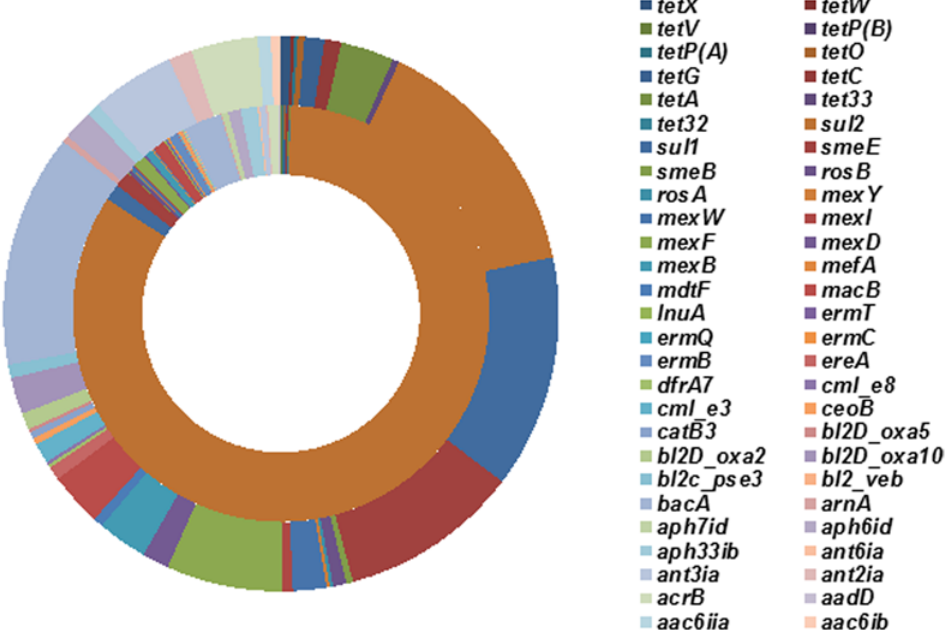
Figure 3. Relative abundance of antibiotic resistance genes (ARGs) in sludge of D6-0 (Inner ring) and D6-20 (Outer ring). After searching in antibiotic resistance database (ARDB), the relative abundance was obtained with the matched sequencing reads normalized to the total reads of each sample. D6-0: sludge incubated with 0 mg/L tetracycline for 6 days; D6-20: sludge incubated with 20 mg/L tetracycline for 6